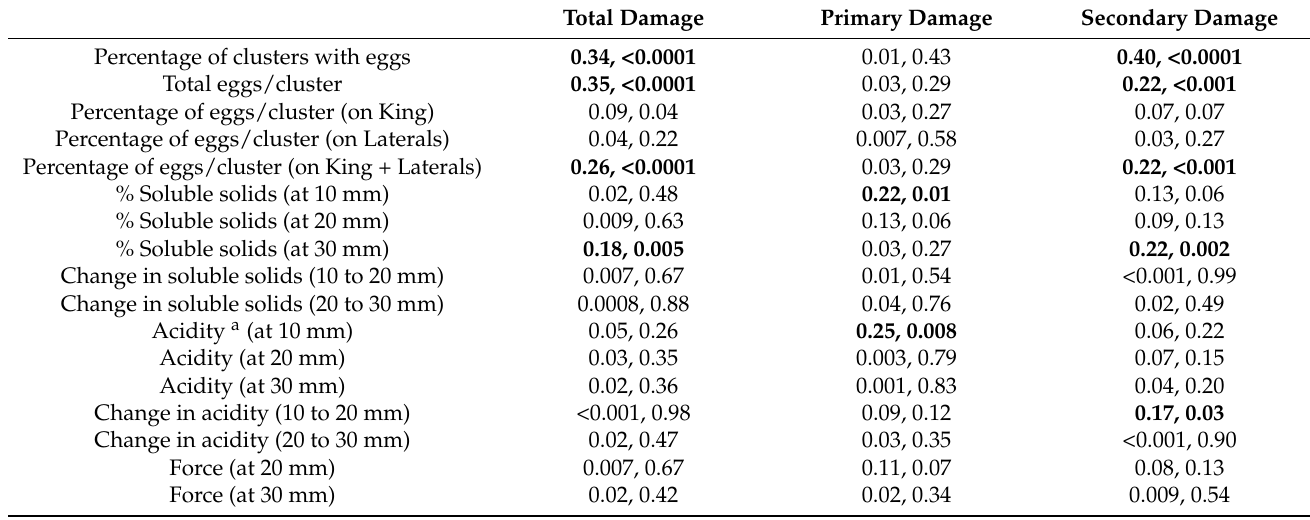
Table 4. R 2 and p -values for relationships between Hoplocampa testudinea eggs (mean percentage of clusters with eggs and mean numbers of eggs per cluster, N = 42), fruitlet chemistry and firmness and observed damage (mean percentage of fruit, N = 43) across 15 apple cultivars from 2 blocks over 3 years (2016, 2018 and 2019) located at the Kentville Research and Development Centre in Nova Scotia.